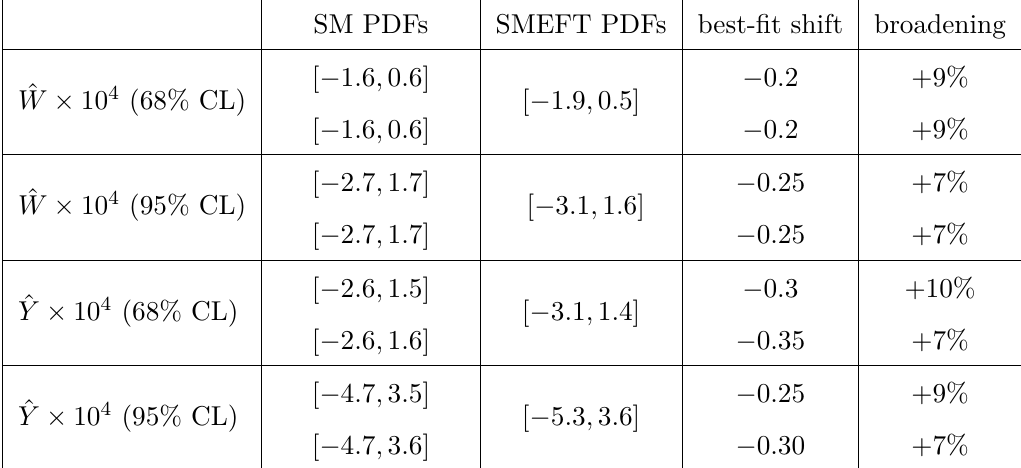
Table 5 . The 68% and 95% CL bounds on the ˆ W and ˆ Y parameters obtained from the correspond- ing parabolic fits to the ATLAS search data of [139] when using either the SMEFT PDFs or their SM counterparts. For the SM PDF results, we indicate the bounds obtained without (upper) and with (lower entry) PDF uncertainties accounted for; the SMEFT PDF bounds already include PDF uncertainties by construction. The fourth and fifth column indicate the absolute shift in best-fit values and the percentage broadening of the EFT parameter uncertainties when the SMEFT PDFs are consistently used instead of the SM